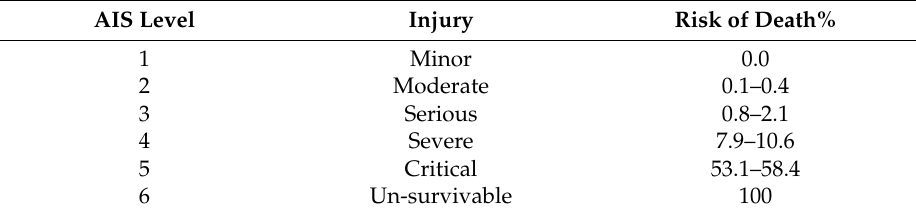
Table 1. Abbreviate Injury Scale (AIS) levels and risk to life